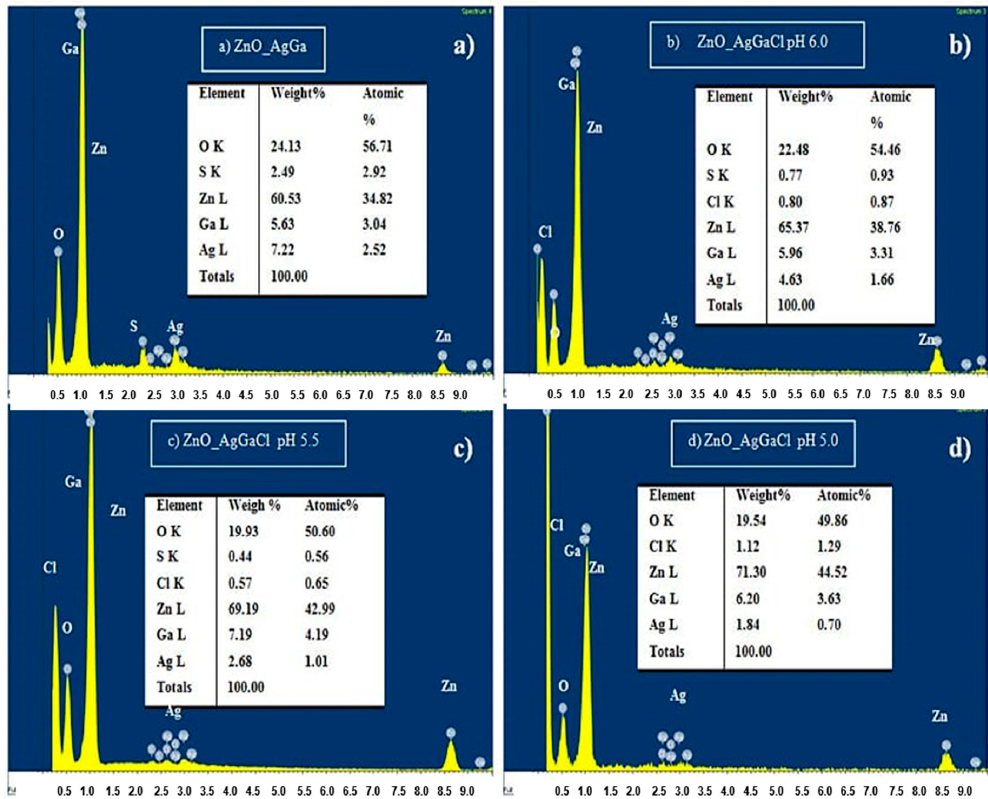
Figure 2. EDX spectra and atomic percent’s of AgGa-doped ZnO NRs: ( a ) pH unmodified and ( b – d ) pH modified.